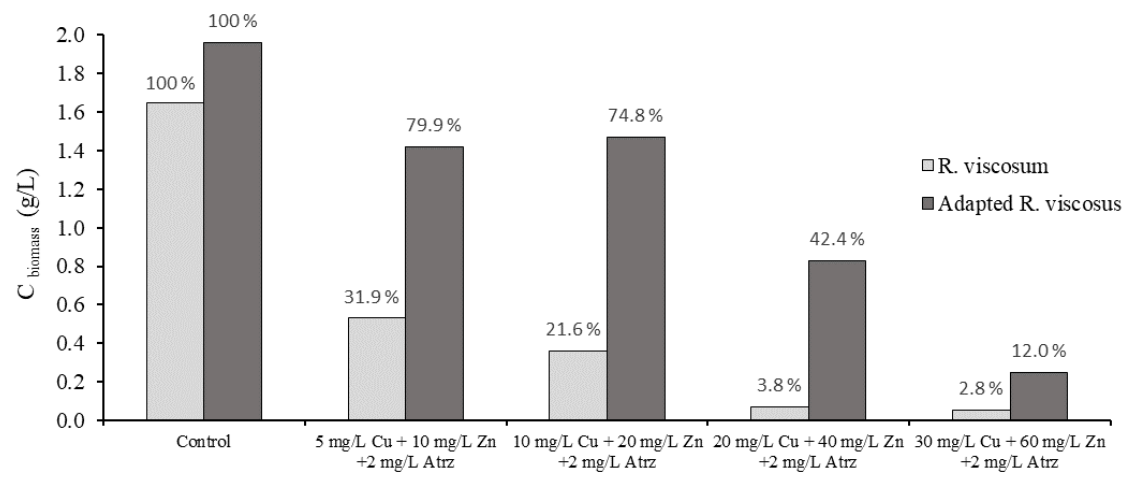
Figure 4. Growth of a pure culture of R. viscosum (adapted and not adapted) after 24 h of exposure to contaminants (atrazine, copper and zinc).